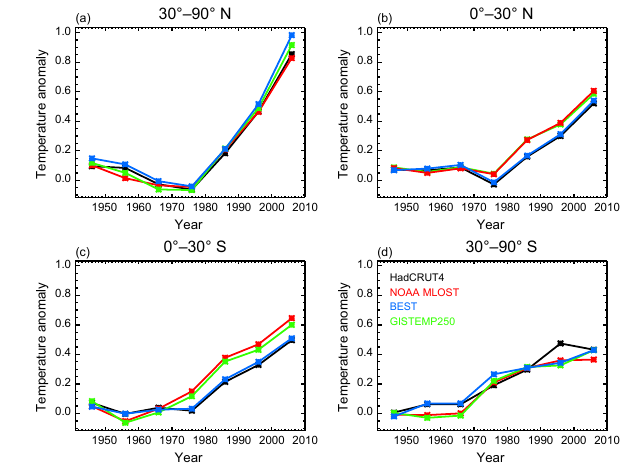
Figure 8. Global mean ocean heat content for the 0–2000m layer. Shading indicates twice the standard error on either side of the es- timate. Also shown are the best fit linear trend lines for the trend beginning in 1955 and ending in 1990 (black), 2000 (red), and 2010 (blue). Dashed lines indicate the 95% confidence interval for the point estimate for a given year based on the best fit line and its un- certainty.